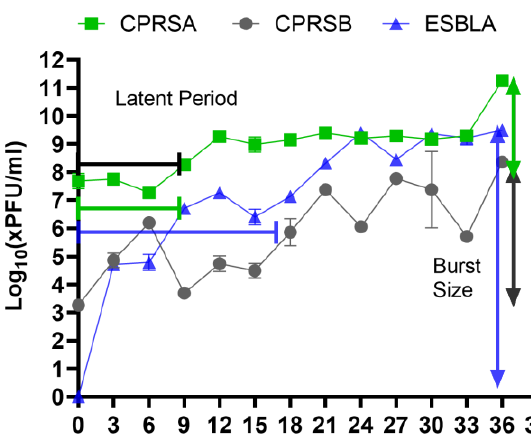
Supplementary Figure 1: One-step growth curves of the precipitated phages isolated from Ruai and Rongai in February 2021. Klebsiella phage CPRSA had the highest burst size (610) and a latent period of 9